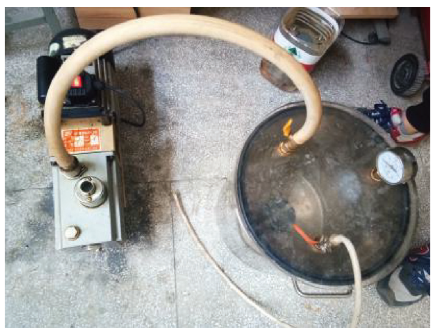
Figure 10: Air exhaust and water saturation of the